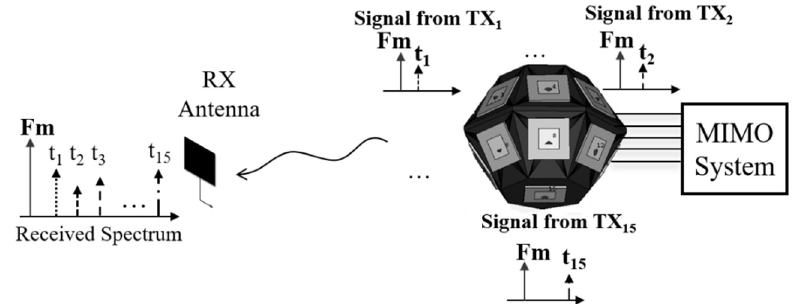
Figure 2. OTA multi-sine technique.